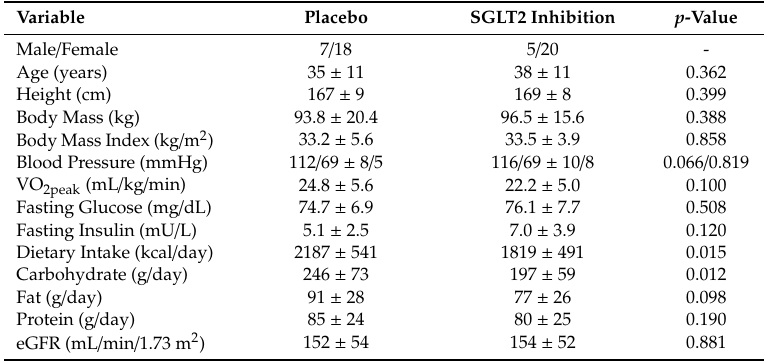
Table 1. Selected baseline physiological and dietary